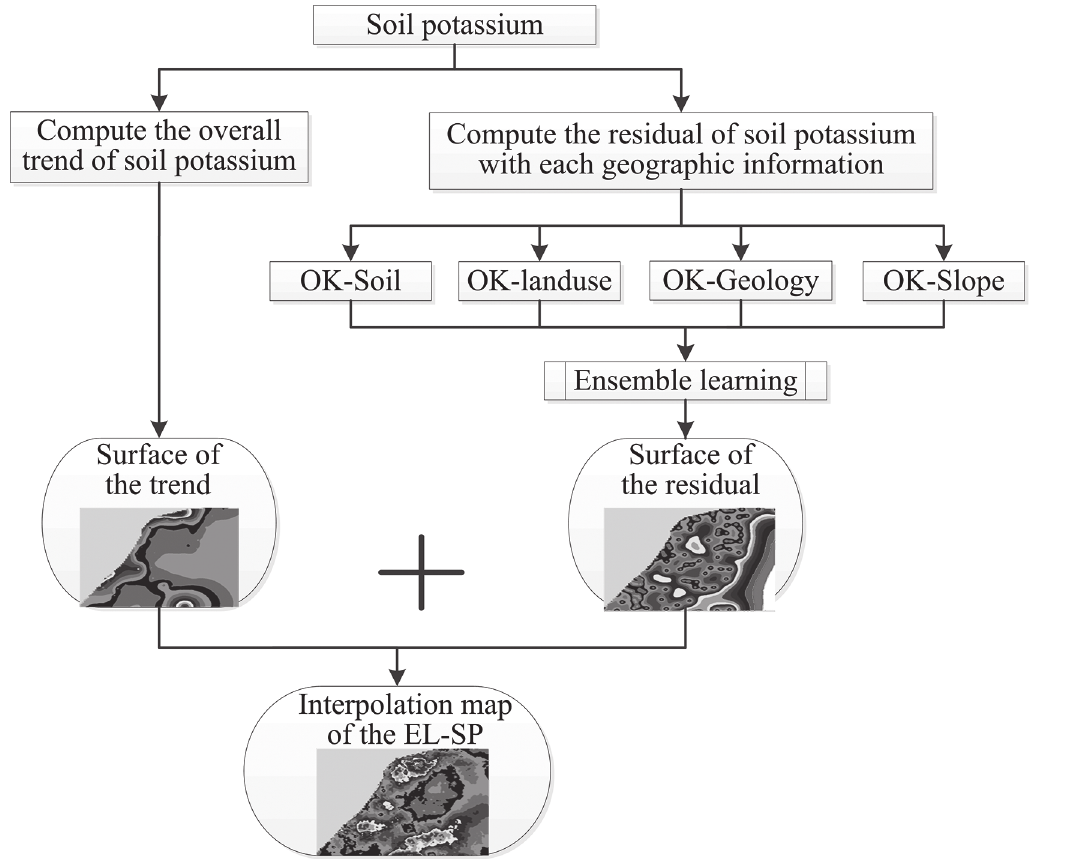
Fig 1. Framework of EL-SP method.